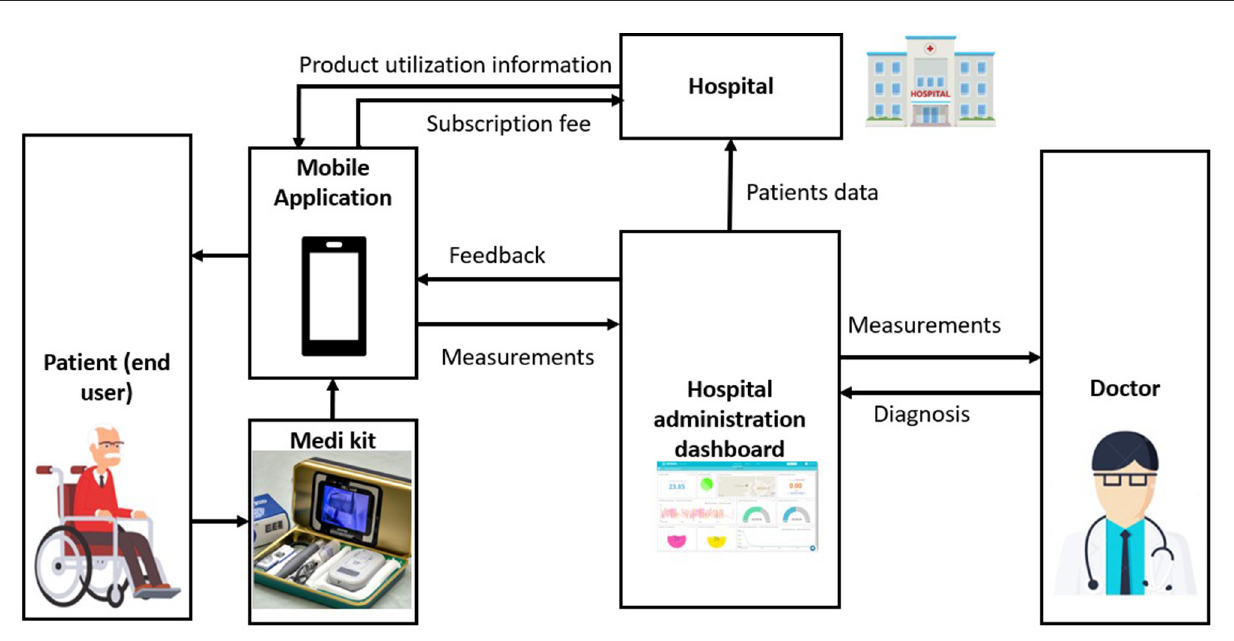
FIGURE1 Flow diagram illustrates a service-based subscription model for Medi